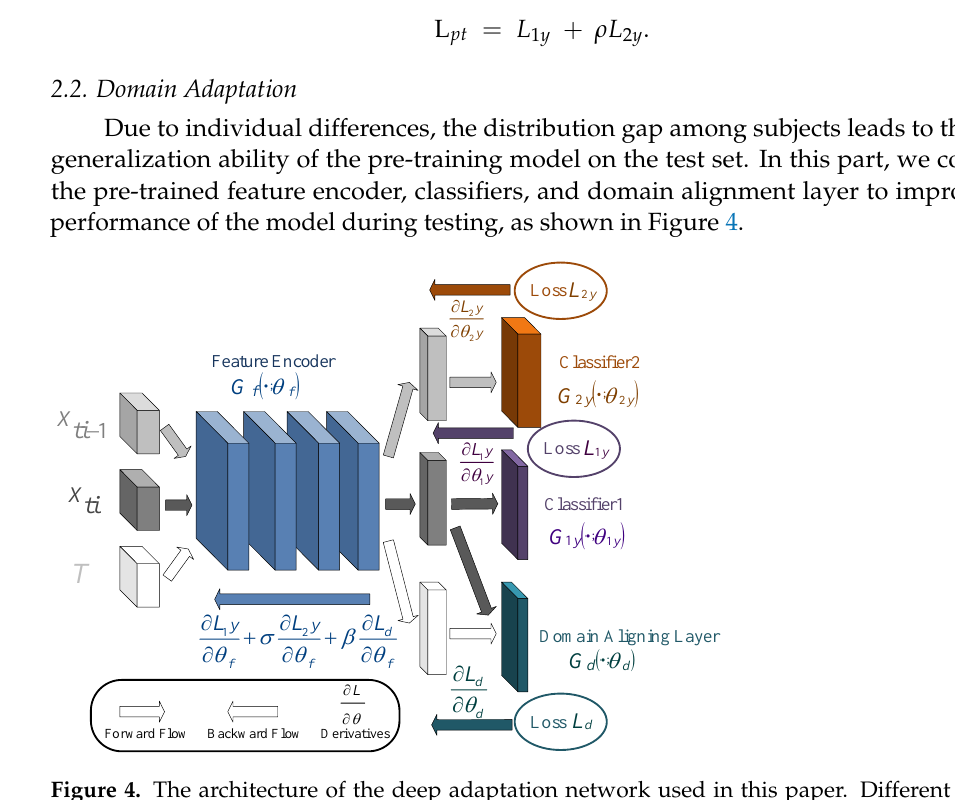
Figure 4. The architecture of the deep adaptation network used in this paper. Different colored arrows indicate the data flow and backpropagation of different branches.